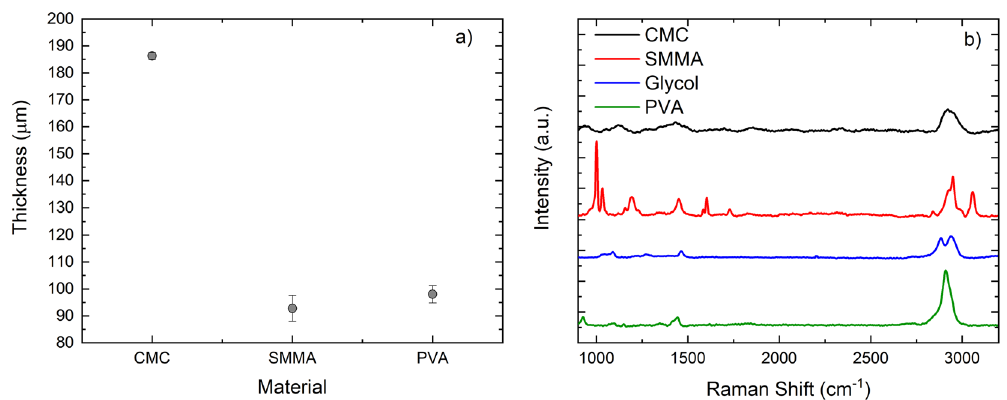
Figure 5. ( a ) Thickness of samples used in the study. ( b ) Raman spectrums of all the samples used in mode- locked